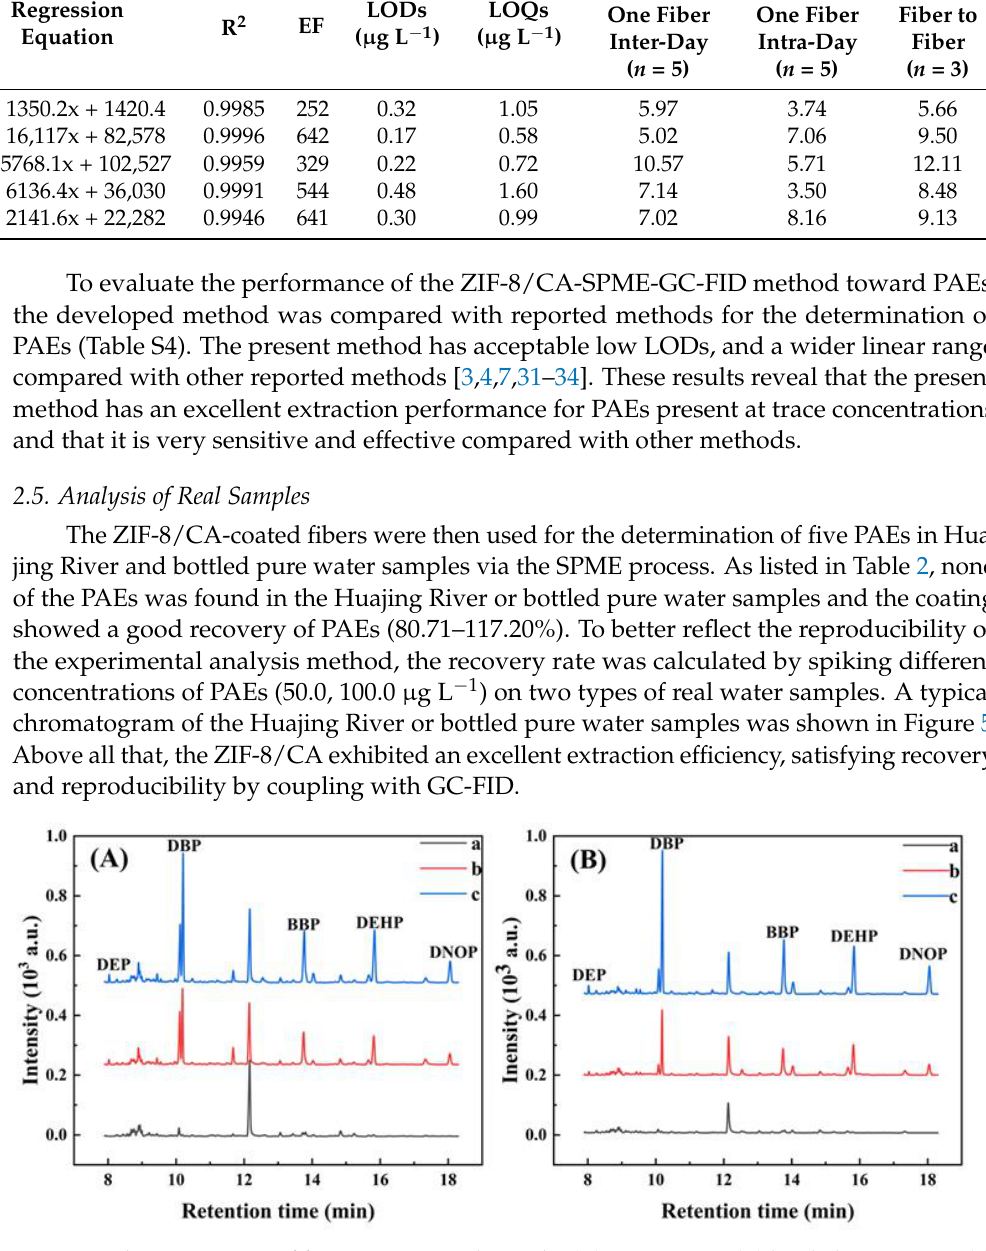
Figure 5. Chromatograms of five PAEs in a real sample. ( A ) River water, ( B ) bottled pure water; (a): blank water; (b): spiked 50 μg L −1 ; (c): spiked 100 μg L −1 . Peak identity is in order: DEP (1), DBP (2),